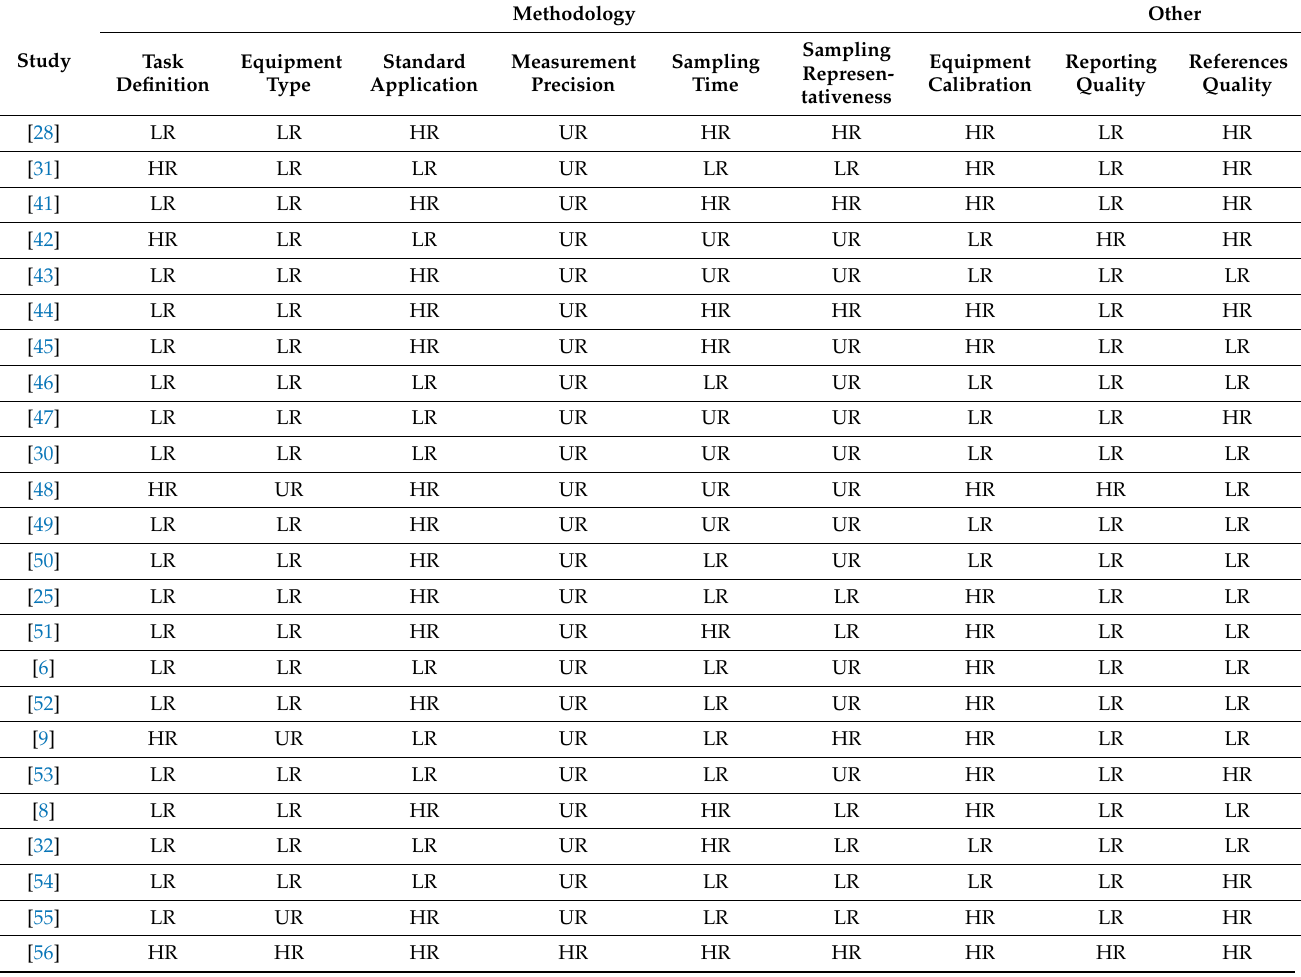
Table 6. Bias analysis of each